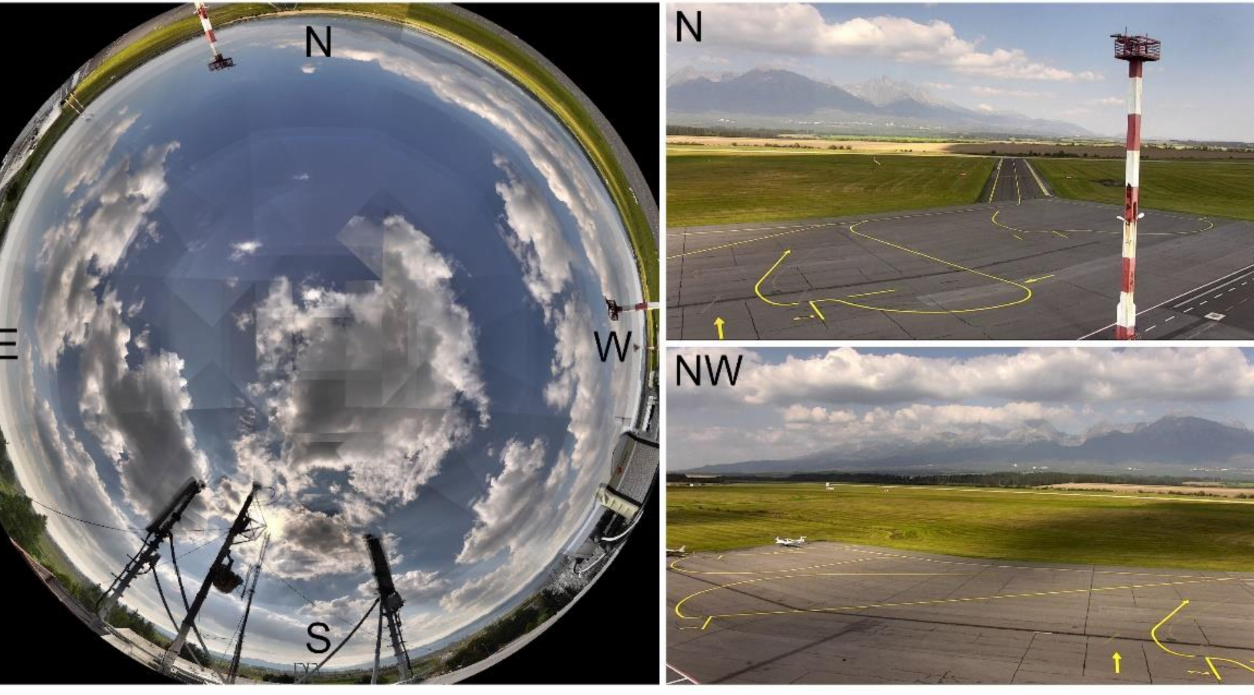
Figure 11. The same as Figure 9, but for 21 September 2018, at 09:20